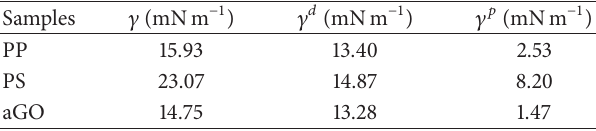
Table 2: Surface energy data of PP, PS, and aGO. Samples